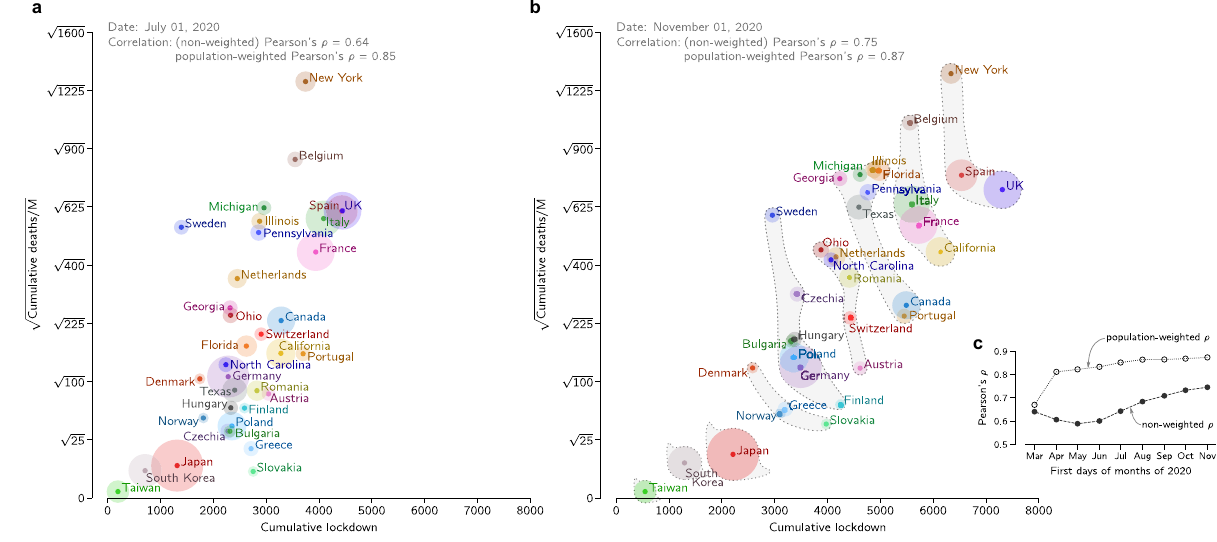
Figure 1. Cumulative mobility reduction (lockdown) and square root of the cumulative COVID-19-assigned deaths per million population for European and East Asian countries, ten US states, and Canada. ( a ) Positions of considered locations as of July 1, 2020. ( b ) Positions of considered locations as of November 1, 2020, and fuzzy Pareto fronts. In ( a ) and ( b ), disk area of each location is proportional to its population. ( c ) Pearson’s correlation coefficients between cumulative mobility reduction and square root of the population-normalized cumulative number of COVID-19-assigned